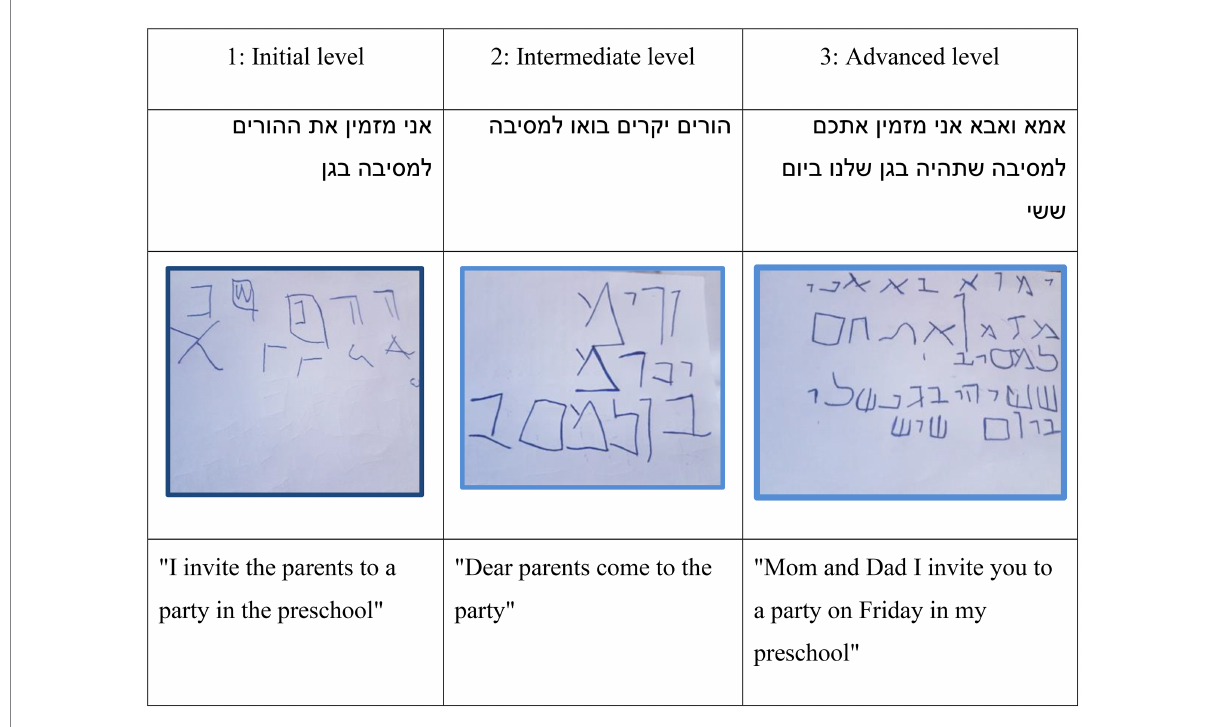
FIGURE 1 The writing